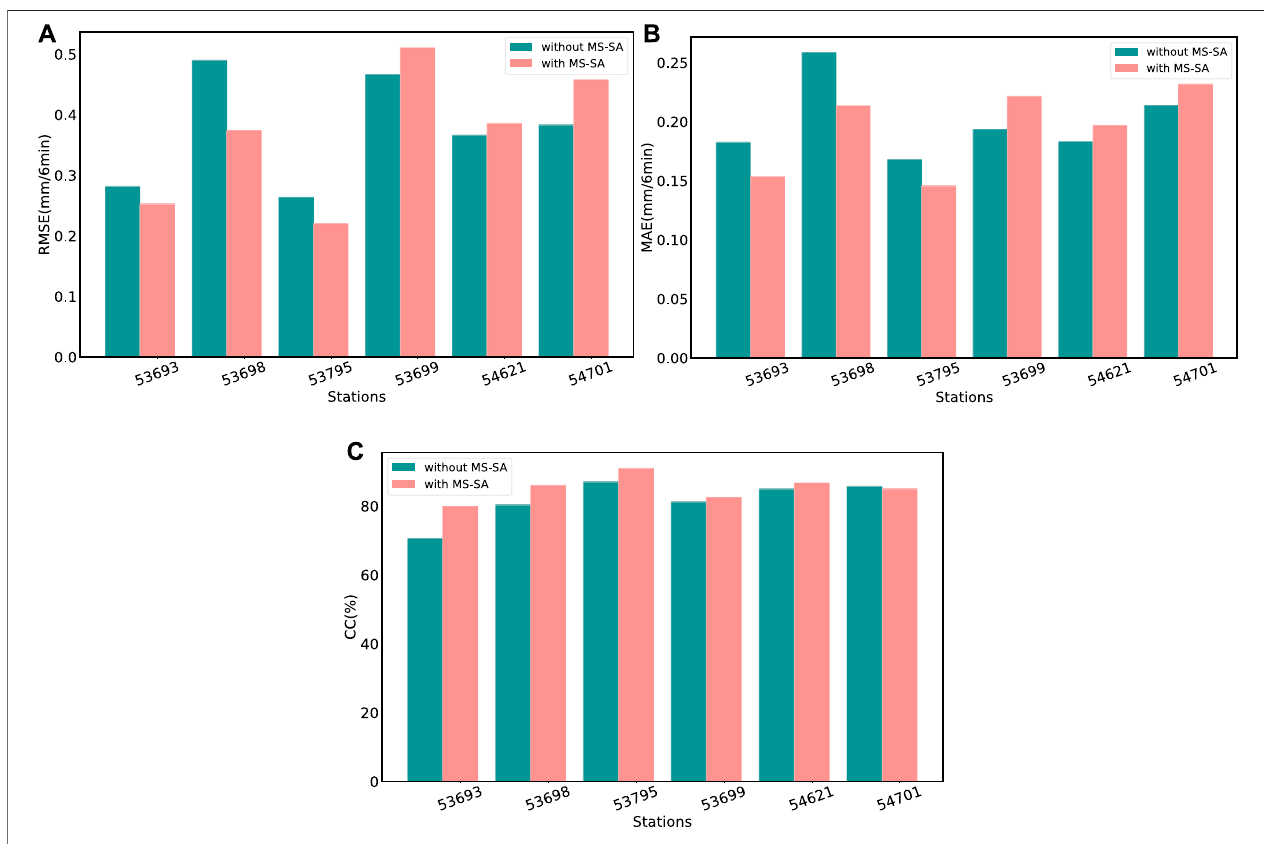
FIGURE 8 | Model incorporation of elevation and MS-SA modules for (A) RMSE scores, (B) MAE scores (C) CC scores at the southwestern Shijiazhuang NWSs 53693, 53698, 53795 and the northeastern NWSs 53699, 54621, 54701.